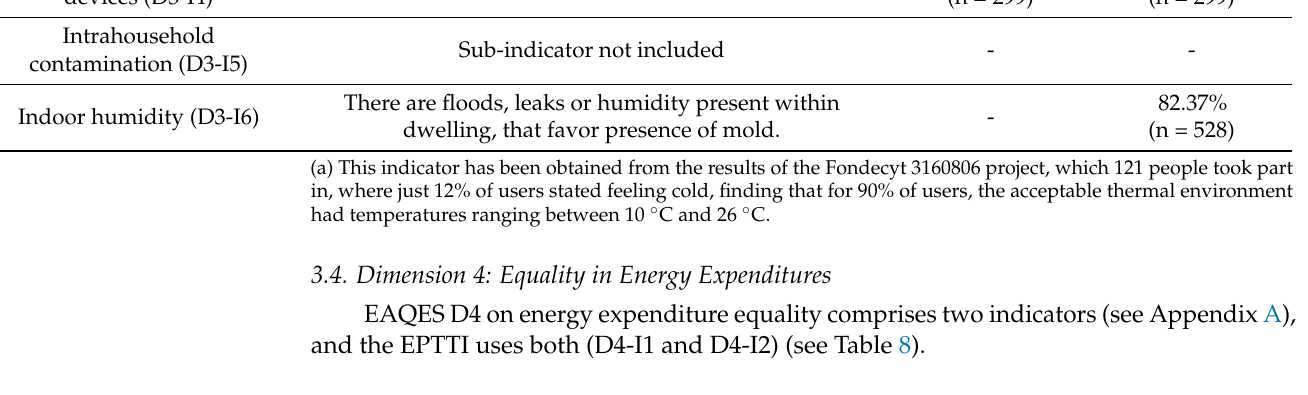
Table 8. Comparison of Dimension 4 indicators between original and adapted